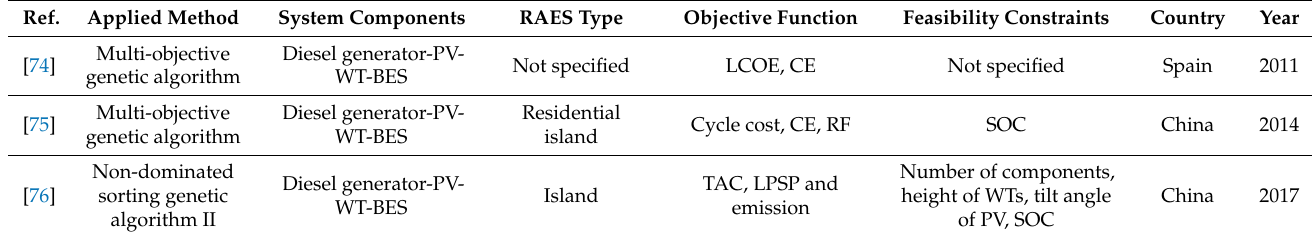
Table 5. Multi-objective capacity optimization for hybrid RAES systems with metaheuristic methods.